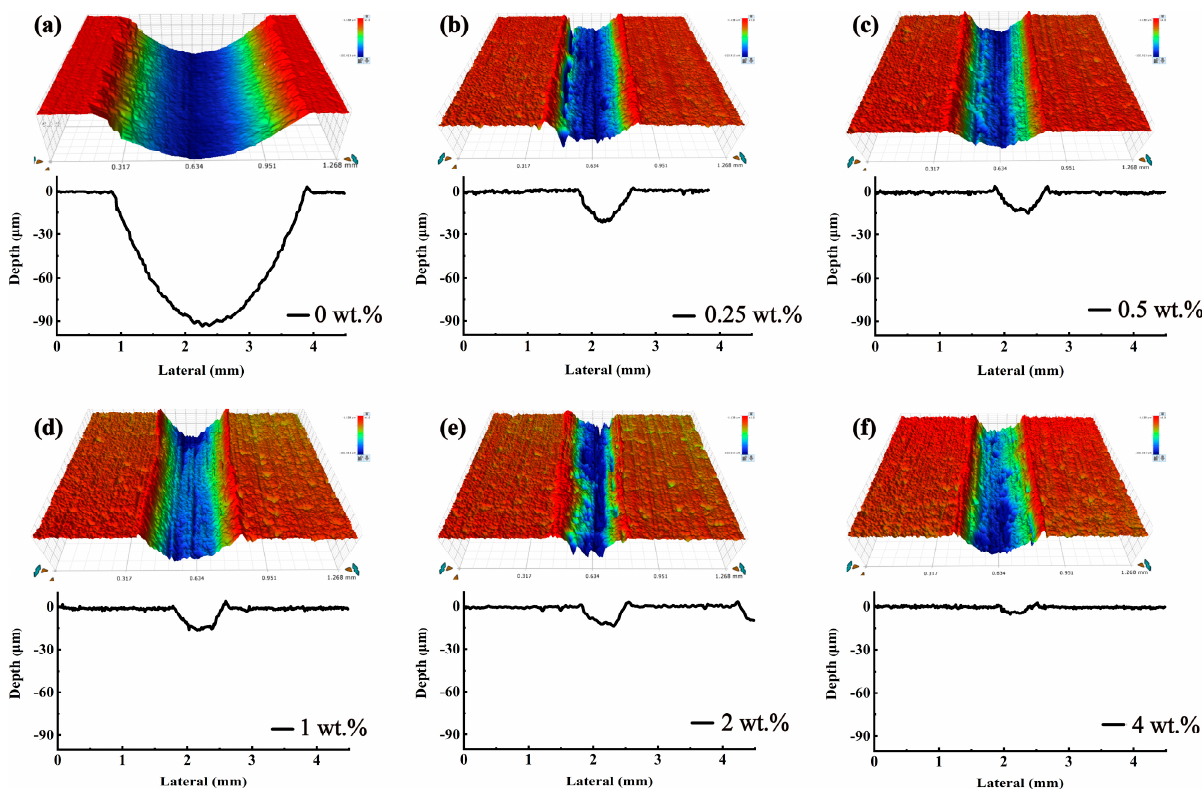
Figure 8. The surface curves and WLI morphologies on worn disks lubricated by the JD2000 water aqueous solutions with different concentrations: ( a ) 0 wt.%, ( b ) 0.25 wt.%, ( c ) 0.5 wt.%, ( d ) 1 wt.%, ( e ) 2 wt.% and ( f ) 4 wt.%.